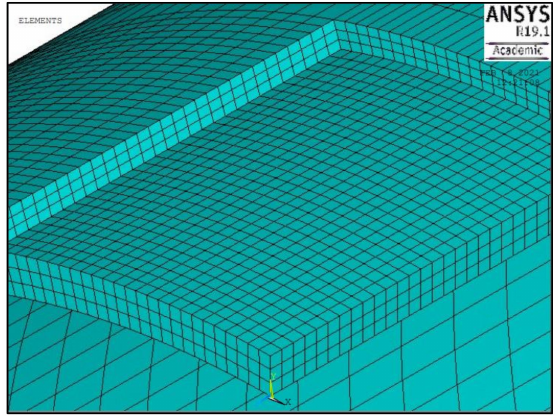
Figure 3. Hexahedral SOLID185 elements used to mesh the pipe body and defect region.